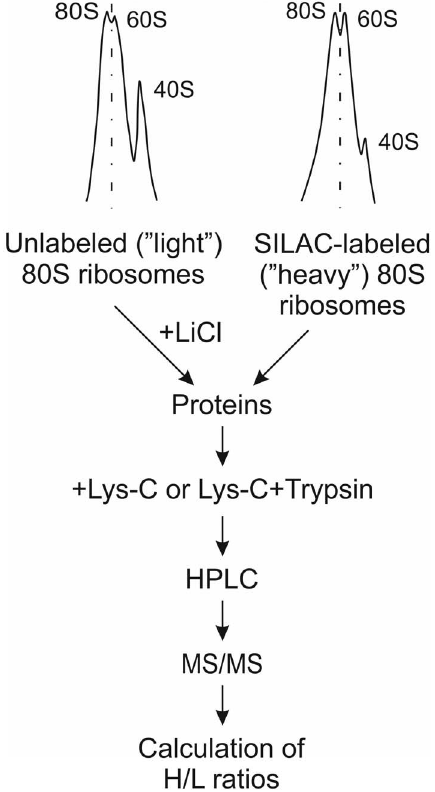
Figure 1. Schematic overview of the experimental approach. Yeast cells were grown in media containing either normal (‘‘light’’) or labeled (‘‘heavy’’) amino acids. Cells were lysed and ‘‘light’’ and ‘‘heavy’’ 80S ribosomes were collected by sucrose gradient centrifugation. After incubation of ‘‘light’’ 80S ribosomes with different concentrations of LiCl, core and supernatant fractions were separated by centrifugation and mixed with ’’heavy’’ ribosomes. Ribosomal proteins were hydro- lysed with Lys-C or with Lys-C + trypsin and peptides were separated by HPLC. ‘‘Heavy’’ to ‘‘light’’ ratio of peptides was determined by MS/MS for each